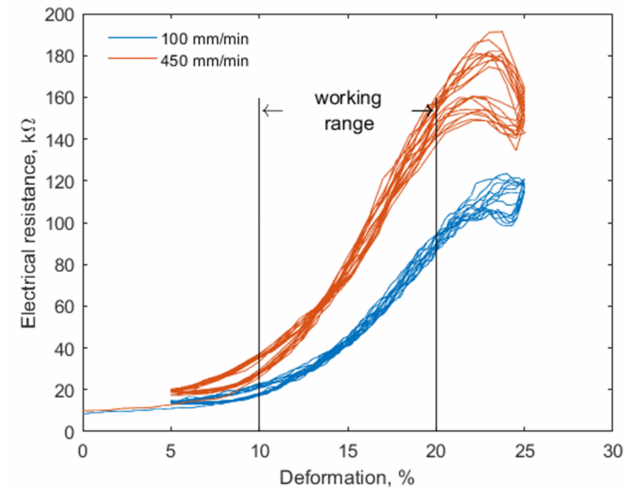
Figure 1. Textile sensor response for dynamic load at 100 and 450 mm / min deformation